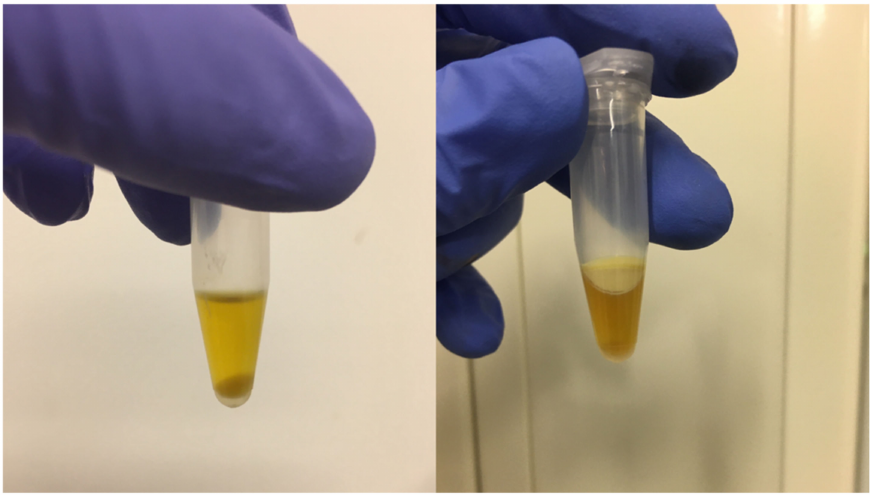
Figure 2. Representative examples of intestinal fluid samples aspirated from the jejunum after intake of Fenogal in the fed state without ( left ) and with ( right ) co-administration of Xenical (orlistat) as lipase inhibitor. After centrifugation, a lipid layer could be clearly distinguished on top of the aqueous micellar layer after orlistat co-administration ( right ) but was absent from jejunal fluids in the fed state without lipolysis